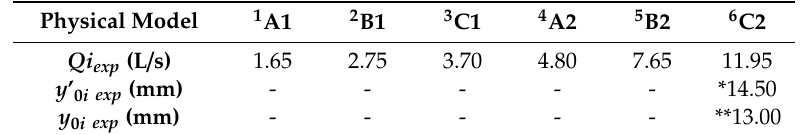
Table2. Experimentalresults: Flowratefortheinitiationofthejetflow Qi exp (L /